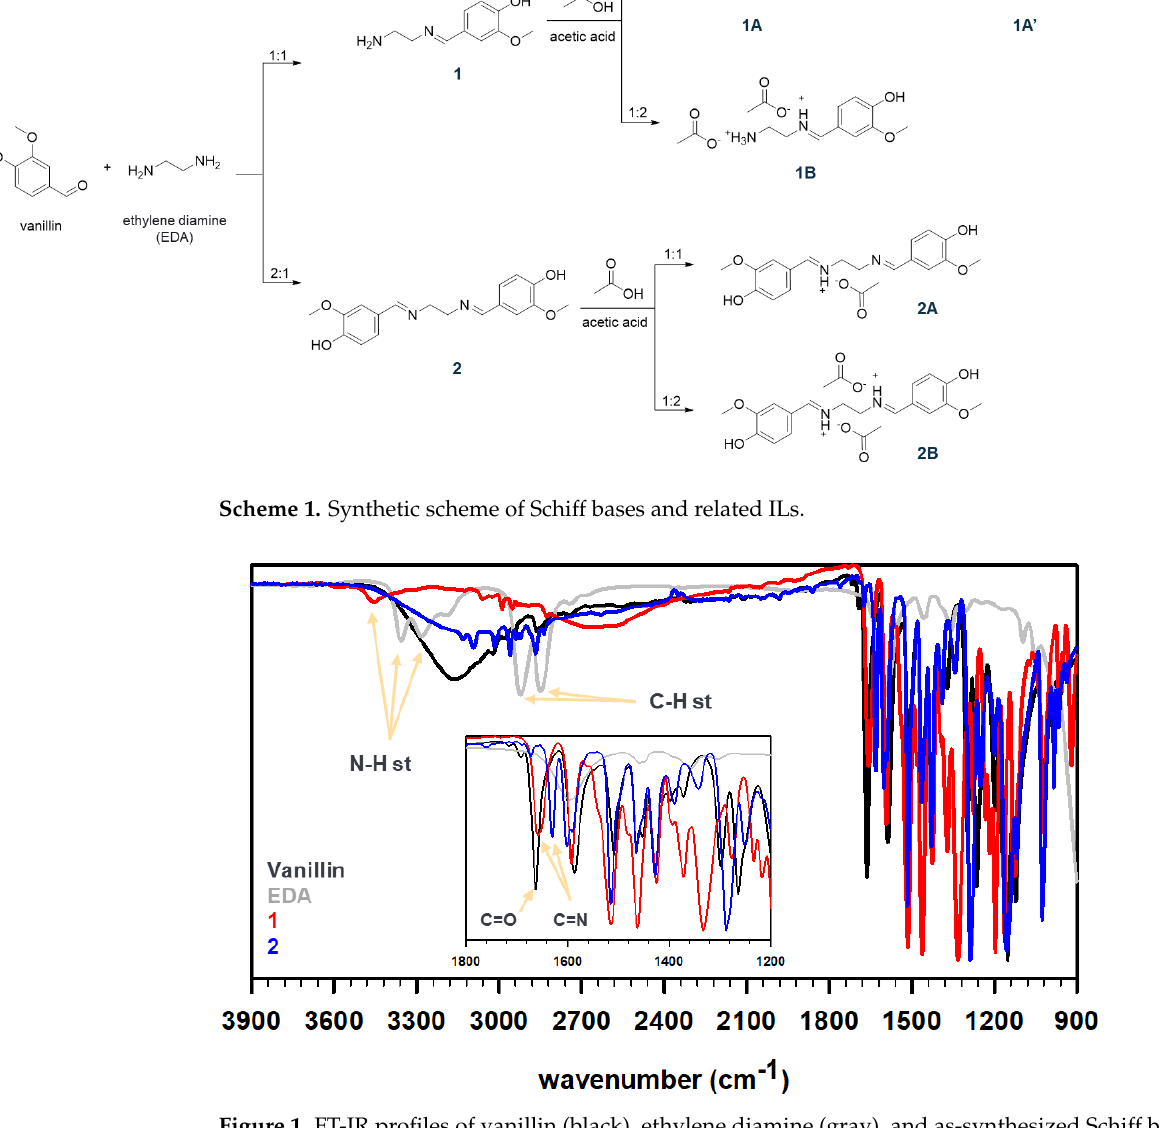
Figure 1. FT-IR profiles of vanillin (black), ethylene diamine (gray), and as-synthesized Schiff bases 1 (red) and 2 (blue). To prepare the ILs, the obtained Schiff bases 1 and 2 were then treated with acetic acid in 1:1 and 1:2 ratios to protonate the imine N-atom in these bases and yield four unique ILs, i.e., 1A , 1B , 2A , and 2B (see Scheme 1). The synthesis protocol reflects the commonly employed acid – base reaction for the synthesis of a protic IL, where a base